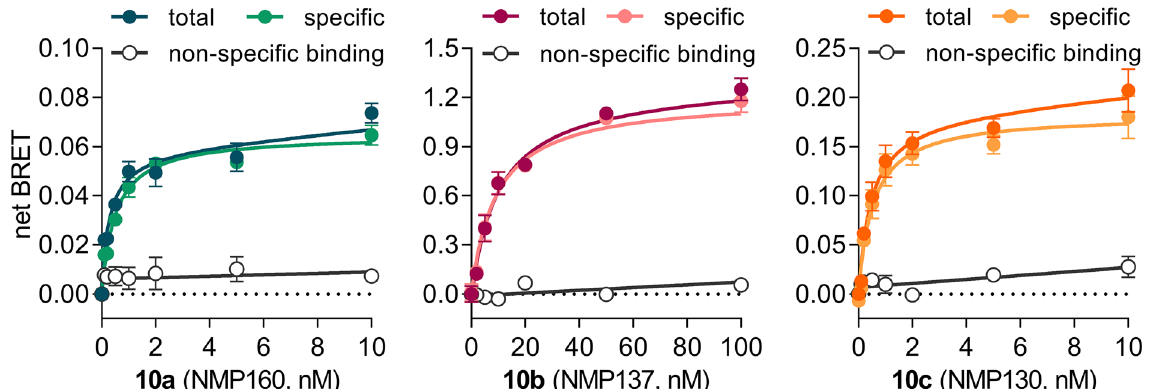
Figure 5. NanoBRET saturation curves for the fluorescent ligands 10a-c . Saturation binding experiments were performed with live HEK293T cells expressing secNluc-D 3 R and the fluorescent ligands 10a , 10b and 10c , comprising a trifluorethyl-rhodamine derivative, a Cy3B and an Alexa488 fluorophore, respectively. Non-specific binding was determined in the presence of 10 µM haloperidol. Data points show mean ± SEM of one representative out of n = 5 (for 10a ) or n = 4 (for 10b , c ) experiments, with each condition carried out in triplicate. The netBRET signal was calculated as the difference between total BRET and the signal obtained in the absence of a fluorescent ligand.